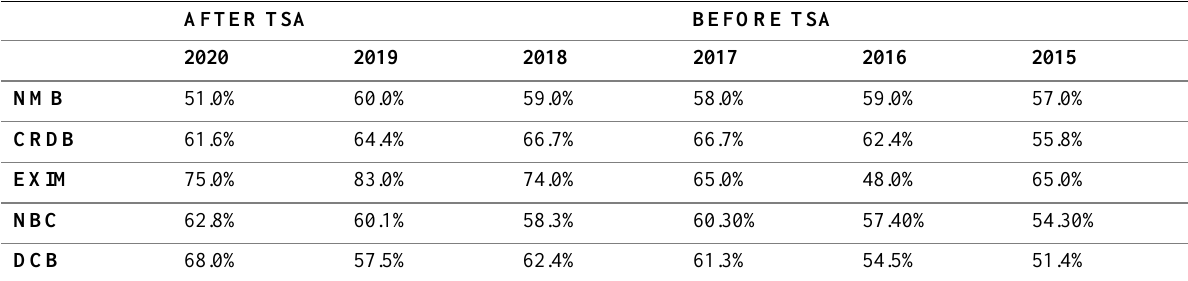
Table 4: Cost-To-Income Ratio and Bank’s